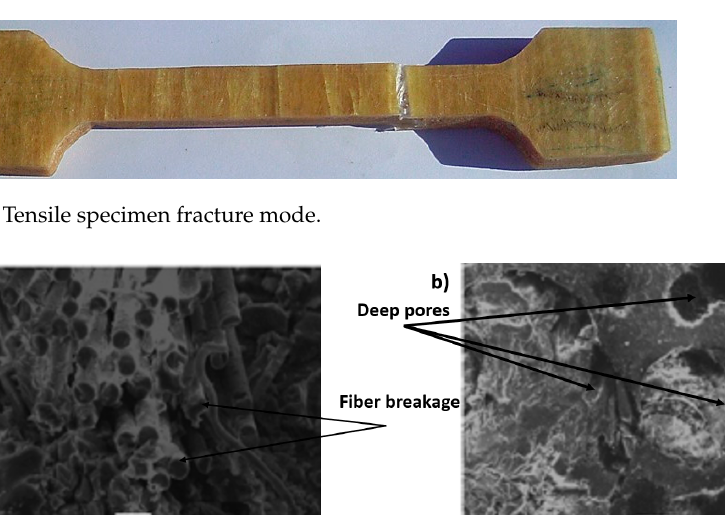
Figure 8. Effect of preconditioning on the stress and strain curves of composite pipes.